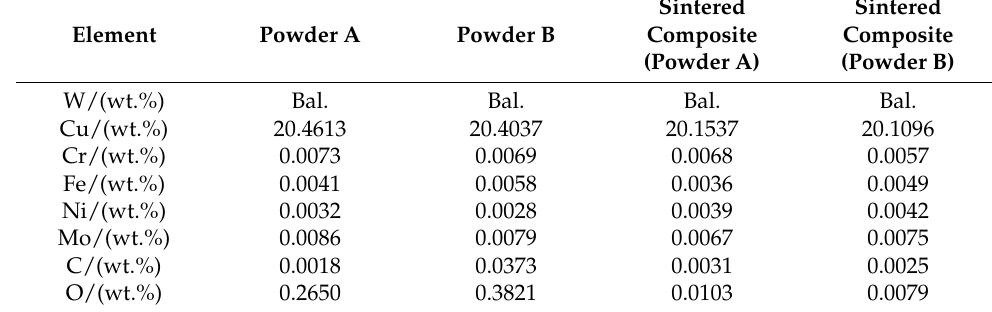
Sintered Sintered Composite Composite (Powder A) (Powder B)